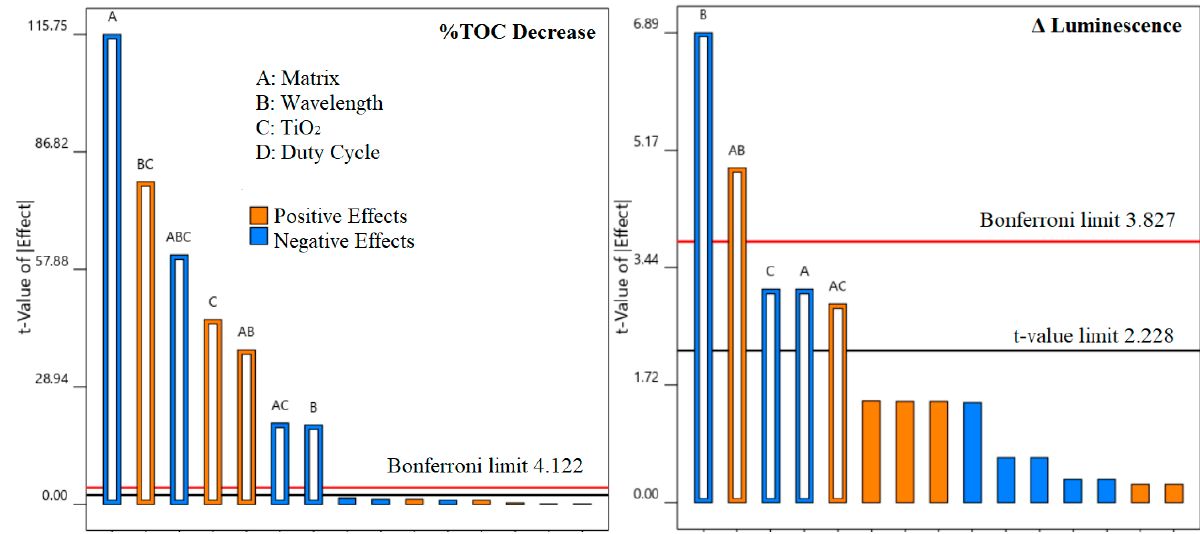
Figure 4. Pareto charts and significant effects (above Bonferroni limit) for %TOC decrease and Δ luminescence.